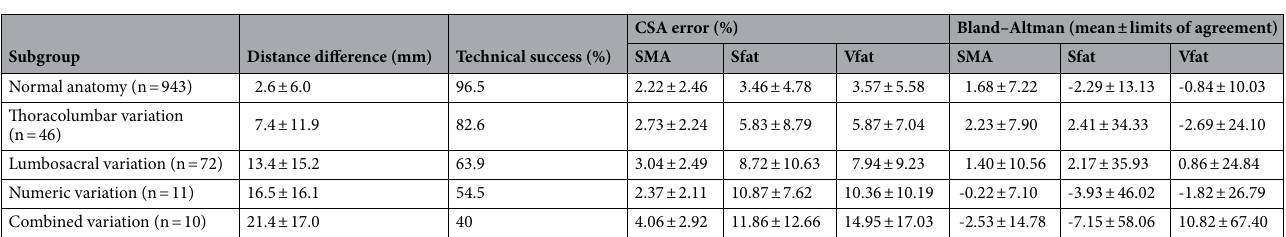
Table 3. Subgroup analysis according to spine anatomy. CSA cross-sectional area, Sfat subcutaneous fat area, SMA skeletal muscle area, Vfat visceral fat